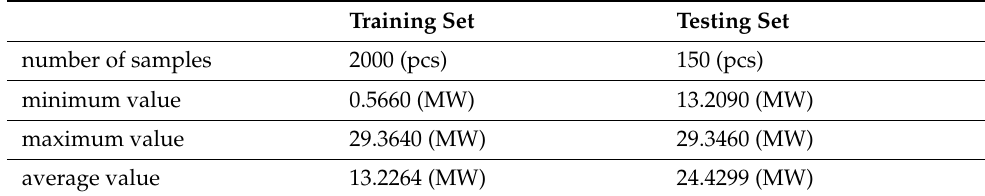
Table 6. Attributes of training set and test set samples.